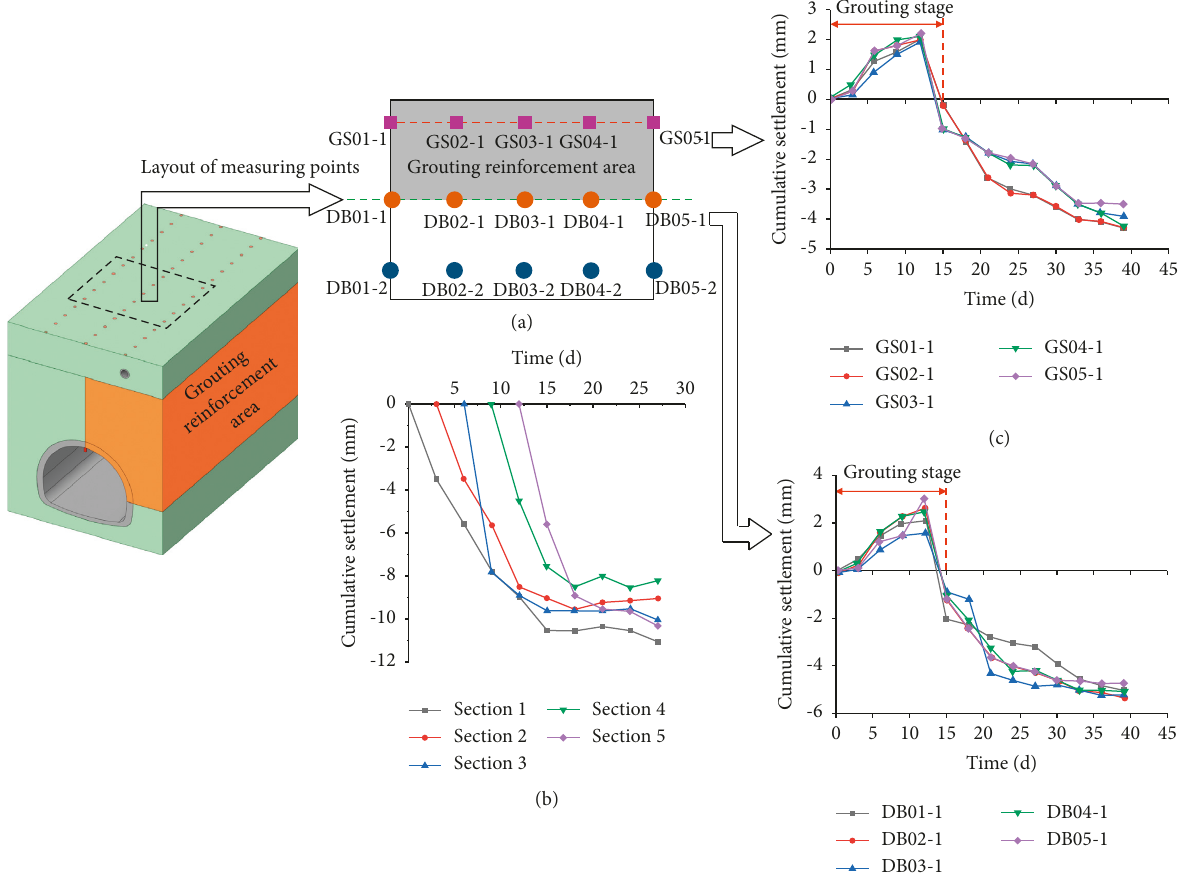
Figure 5: Variation curve of tunnel crown settlement, surface and pipeline cumulative settlement with time (a). Surface displacement measuring point. (b) Variation curve of vault settlement. (c) Variation curve of cumulative settlement of pipeline measuring point (GS0X-1). (d) Variation curve of cumulative settlement of surface measuring point